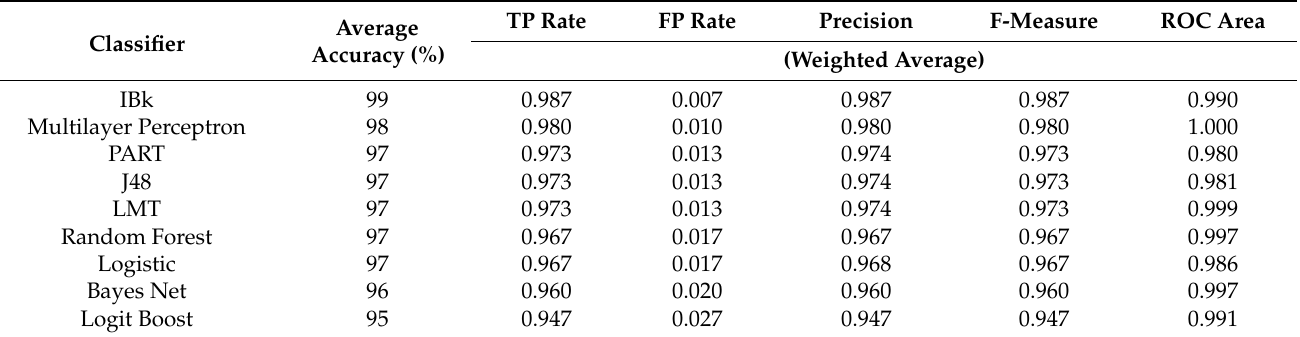
Table 1. The results of potato cultivar discrimination of “Irga”, “Riviera” and “Colomba” using the model built based on selected textures of tuber images converted to individual color